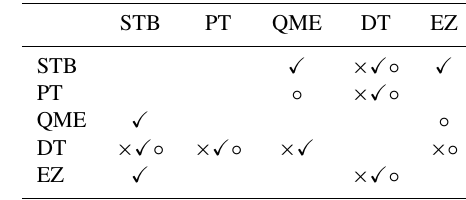
Key: × – Upper Zambezi, (cid:88) – Lower Zambezi, ◦ – Middle